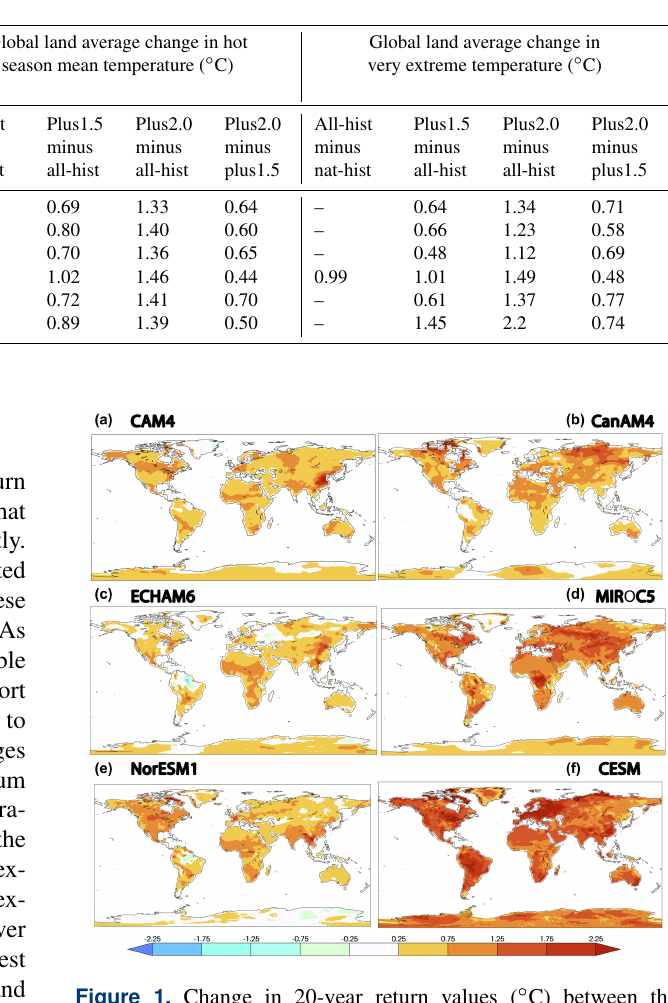
Table 1. Details of the HAPPI models used in this study. The number of realizations for each part of the numerical experiment is used separately in this study. For some individual years of the all-hist and nat-hist simulations, additional realizations may be available. The two rightmost columns show the globally averaged difference between selected combinations of the hot season temperature and the 20-year return value of the annual maximum 3-day average daily maximum surface air temperature (TX3x) over land. “Hot season” is defined as the maximum of June, July and August (JJA) and December, January and February (DJF) averages. Plus2.0 denotes the 2 ◦ C stabilization scenario and plus1.5 denotes the 1.5 ◦ C stabilization scenario. Note that CESM1 is not part of the HAPPI experiment but a fully coupled ocean-atmosphere climate model that has been run with emissions scenarios consistent with both targets. The CESM1 experiments are roughly comparable to the HAPPI experiment but not exactly the same forcing or reference period.